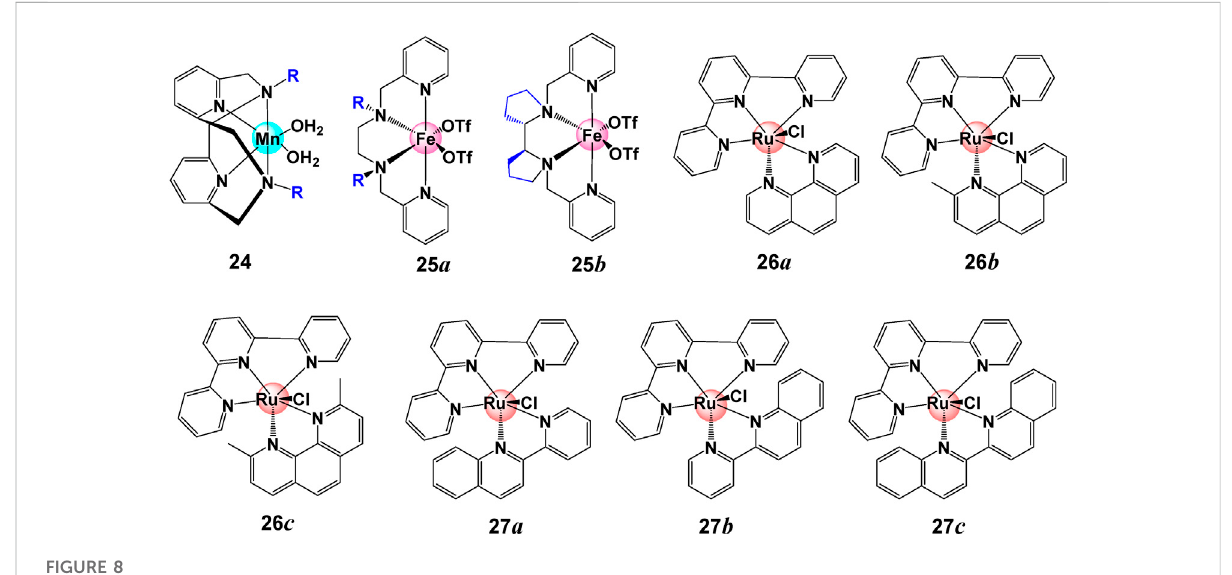
FIGURE 8 Chemical structures of complexes 24 – 27